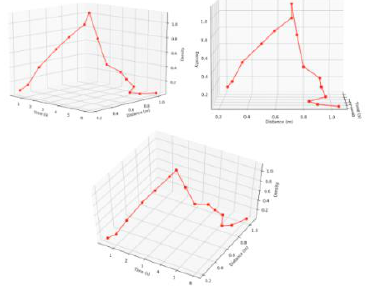
Figure 12. 3D Graph of Cigarette Smoke Density vs Time vs Extent Relative from the Source in an Indoor